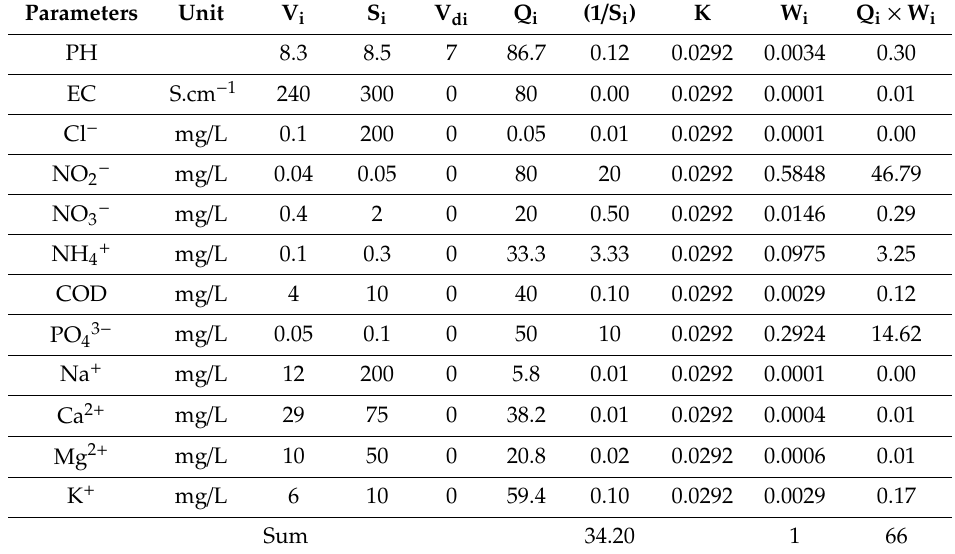
Table 7. Weighted arithmetic water quality index (WAWQI) calculation for sampling Number 2 as an example in the dry